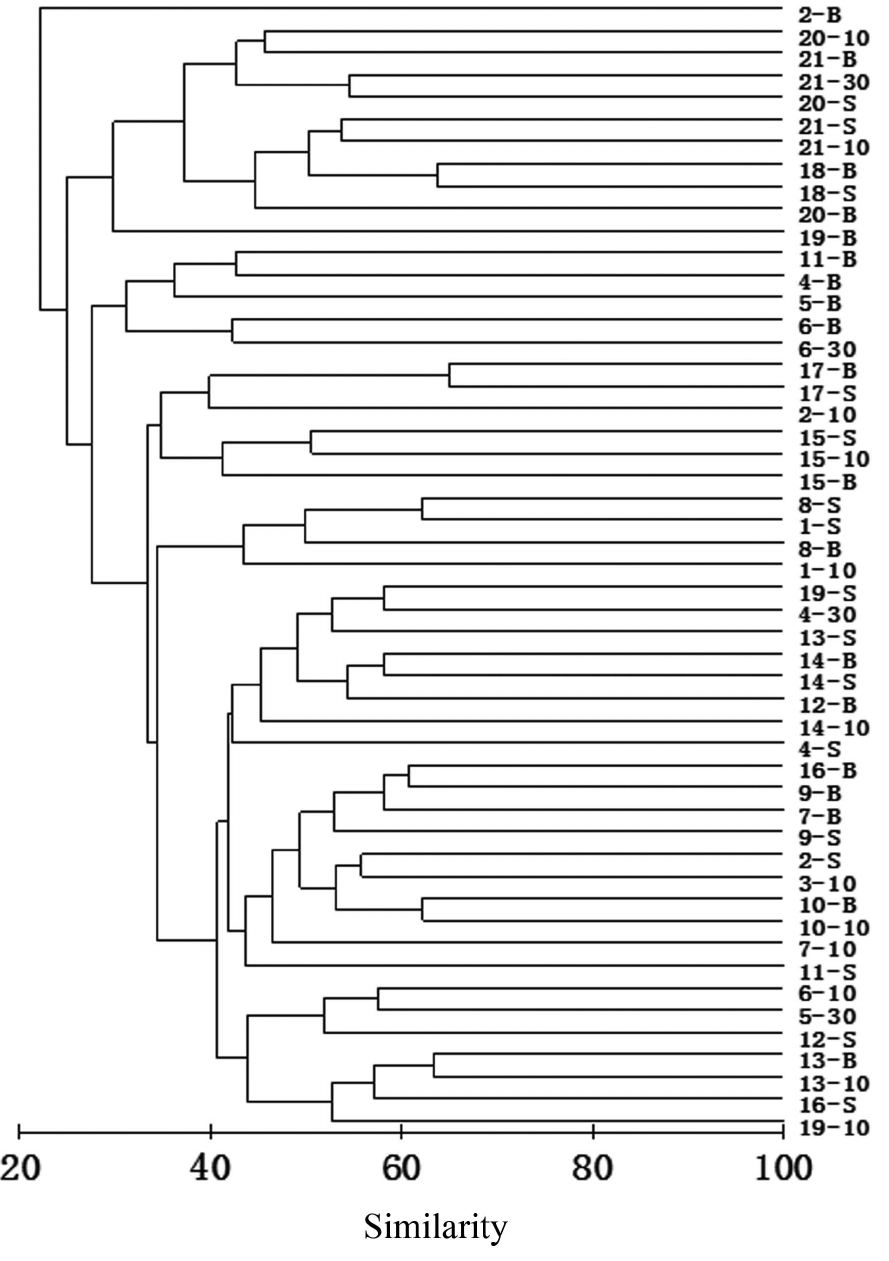
Figure 9. Result of cluster analysis. The result was based on Bray-Curtis similarities from square root-transformed biotic data of 51 effective samples in the northern Beibu Gulf in August 2011. The numbers indicated the sampling stations. -S = surface-layer sample; 2 10=10 m-layer sample; 2 30=30 m-layer sample; -B = bottom-layer sample. (TIFF).